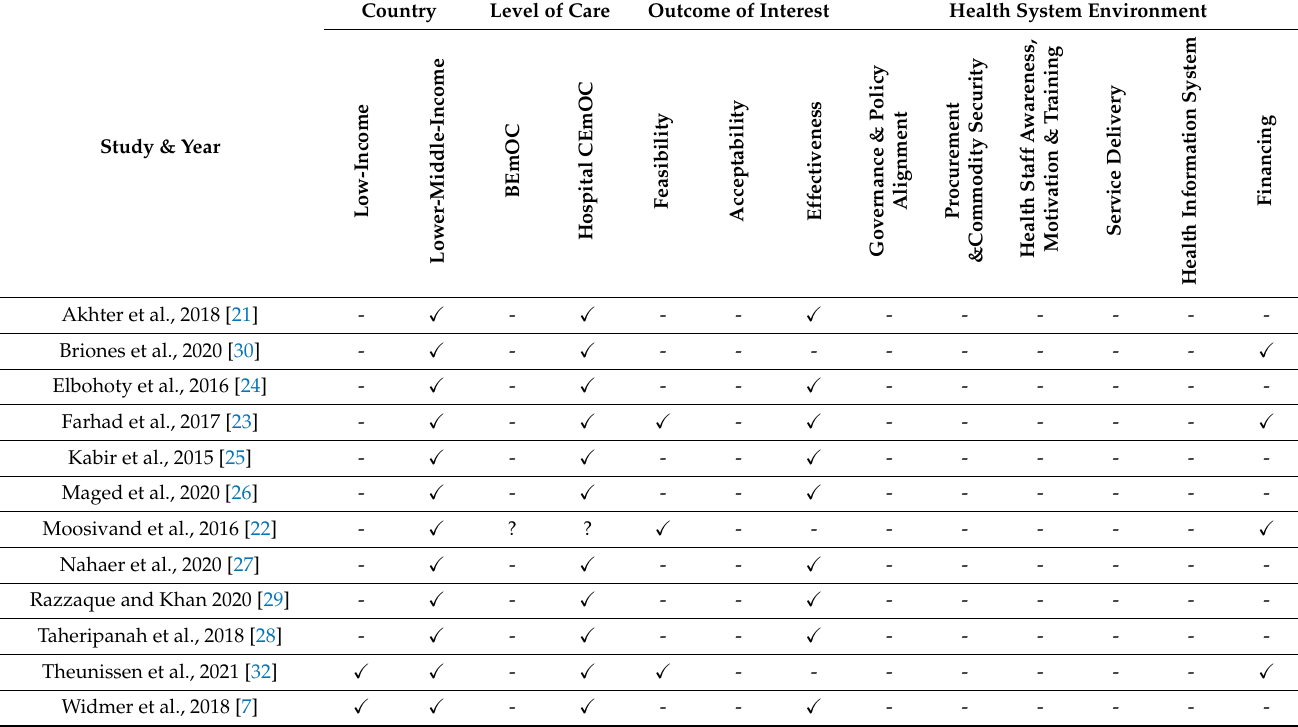
Table 3. Contexts and main concepts of included